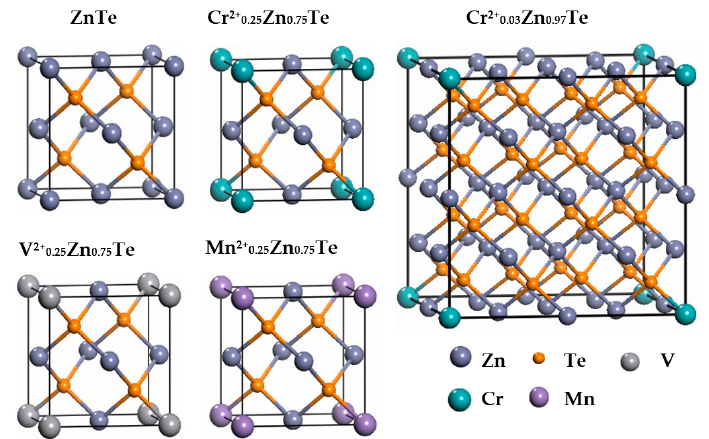
Figure 1. Atomistic representations of 8-atom ZnTe, V 2+0.25 Zn 0.75 Te, Cr 2+0.25 Zn 0.75 Te, Mn 2+0.25 Zn 0.75 Te,